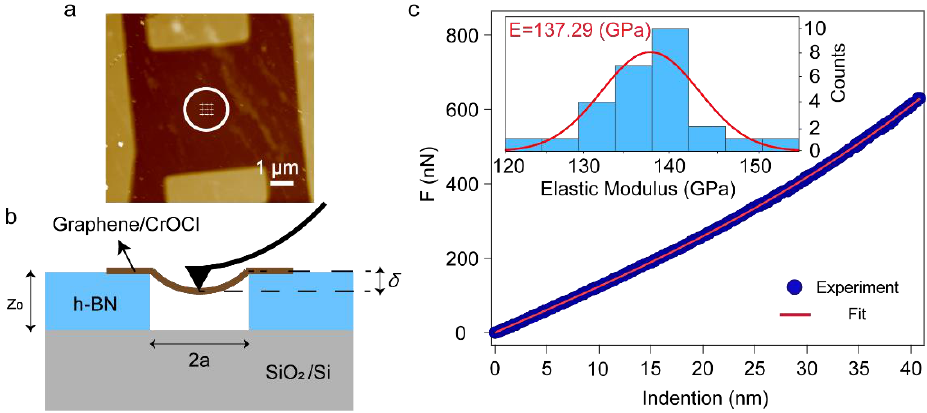
Figure 2. Young’s modulus of the CrOCl resonators. ( a ) Morphology image of a typical CrOCl resonator of dashed blue-boxed area in Figure 1b. Suspended area is depicted by the white solid circle, and the white crosshair represents the position that we applied nano-indention measurement. ( b ) Schematic diagram of force detection of CrOCl resonators. ( c ) Typical force versus indention curve of our device. The inset shows a histogram of the Young’s modulus extracted from 27 points in ( a ). The solid line is a normal fit of the